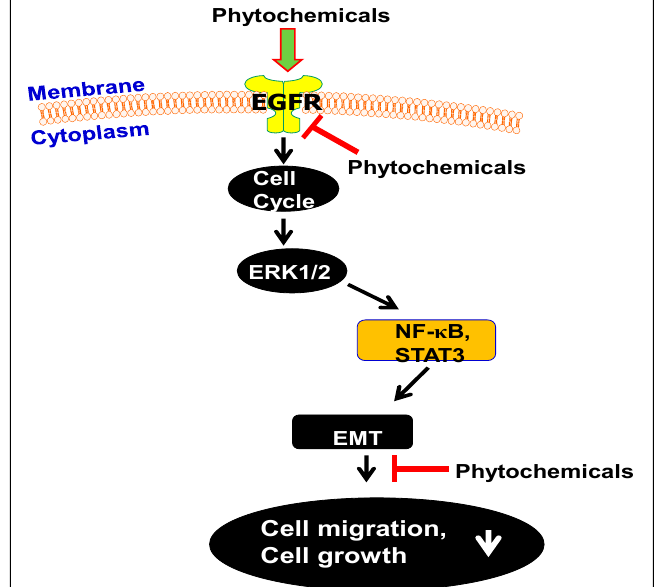
Figure 3. Summary of the action of emerging phytochemicals for the prevention and therapy of HNSCC. Notably, the phytochemicals that were selected based on their efficacy in inhibiting proliferation of HNSCC cells or induction of their apoptosis, all inhibited the expression levels of EGFR in human HNSCC cells. Overexpression of EGFR plays a critical role in cancer cell growth and cancer cell migration/invasion. In general, the inhibition of cell growth and migration capacity of the HNSCC cells by the GSPs, GTPs and honokiol is mediated through their effect on the cell cycle regulatory proteins, EMT and NF- κ B signaling pathway.